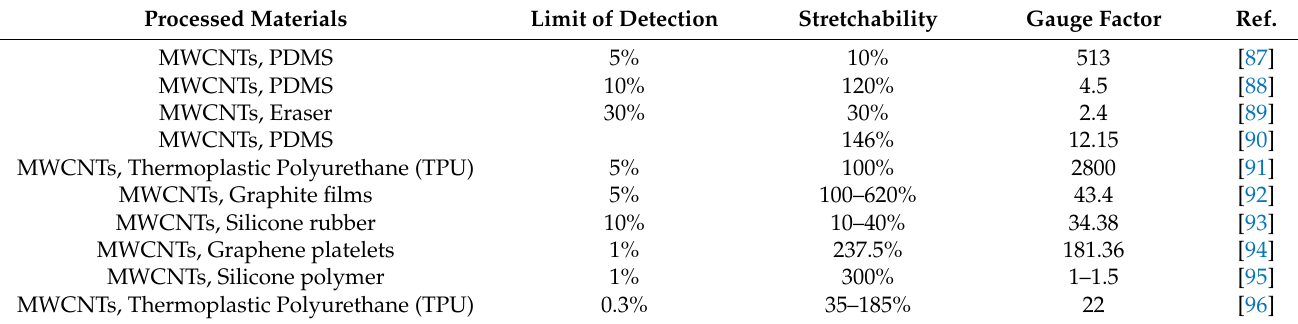
Table 1. Comparative study of some of the significant works done on the use of multi-walled carbon nanotubes (MWCNTs) for strain-sensing